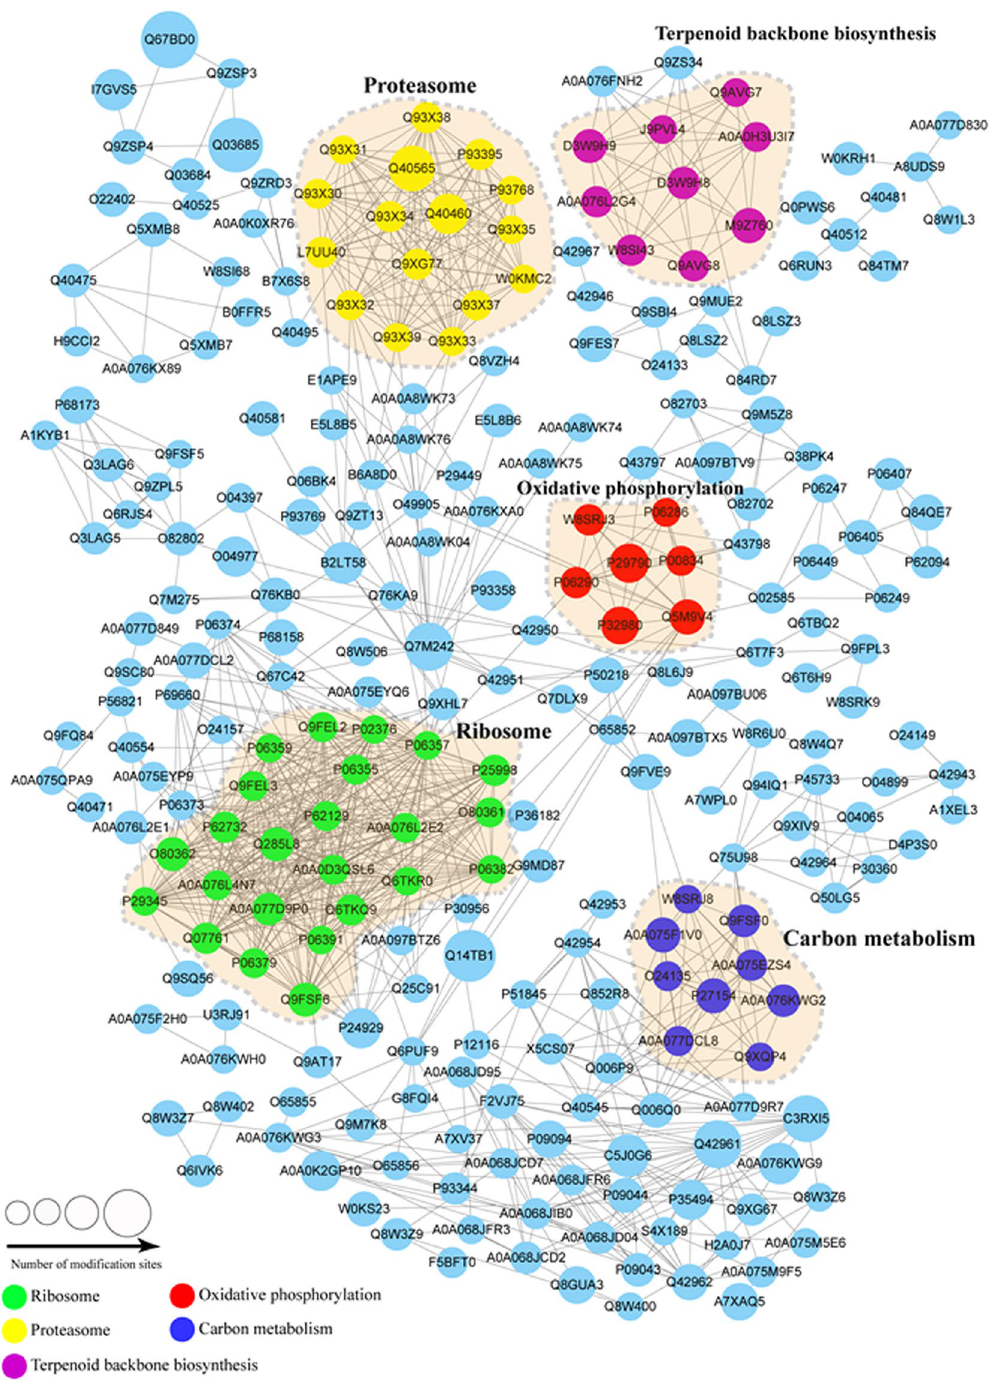
Figure 5. Interaction networks of the crotonylated proteins in